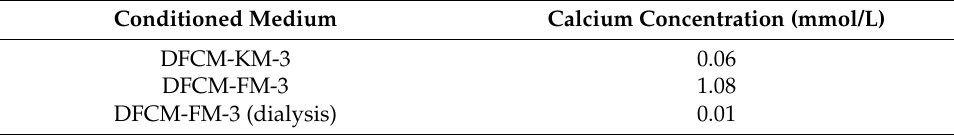
Figure 3. ICC staining of the keratinocyte with vinculin and integrin- β 1 marker. ( A ) Representative images of keratinocytes stained with F-actin (green), DAPI (blue), and vinculin (red). Arrow shows expression of vinculin on the tip of stress fibres. Scale bar: was 100 µ m. ( B ) Representative images of keratinocytes stained with F-actin (green), DAPI (blue), and integrin- β 1 (red). Arrow shows filopodia with expression of integrin. Scale bar: 100 µ m. Table 3. Concentration of calcium chloride in DFCM-KM-3, DFCM-FM-3, and after DFCM-FM-3 dialysis using a dialysis